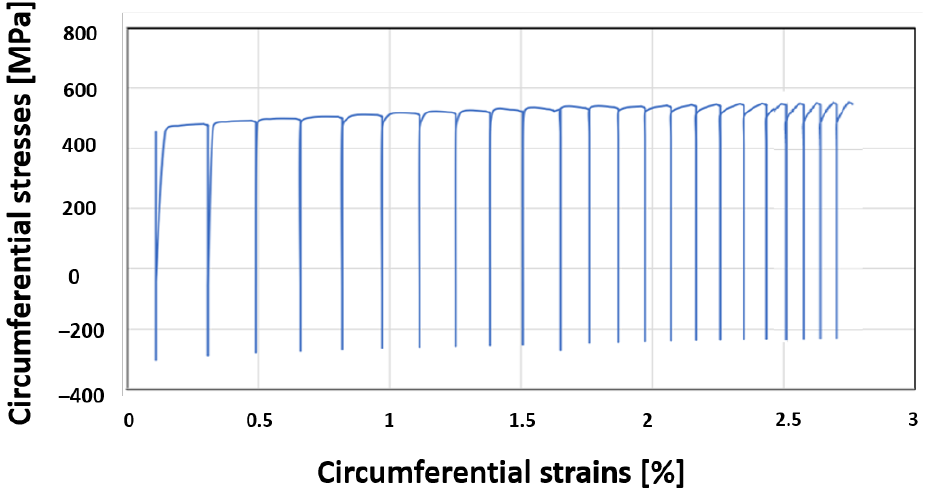
Figure 16. Equivalent plastic strain vs. time—25 cycles.